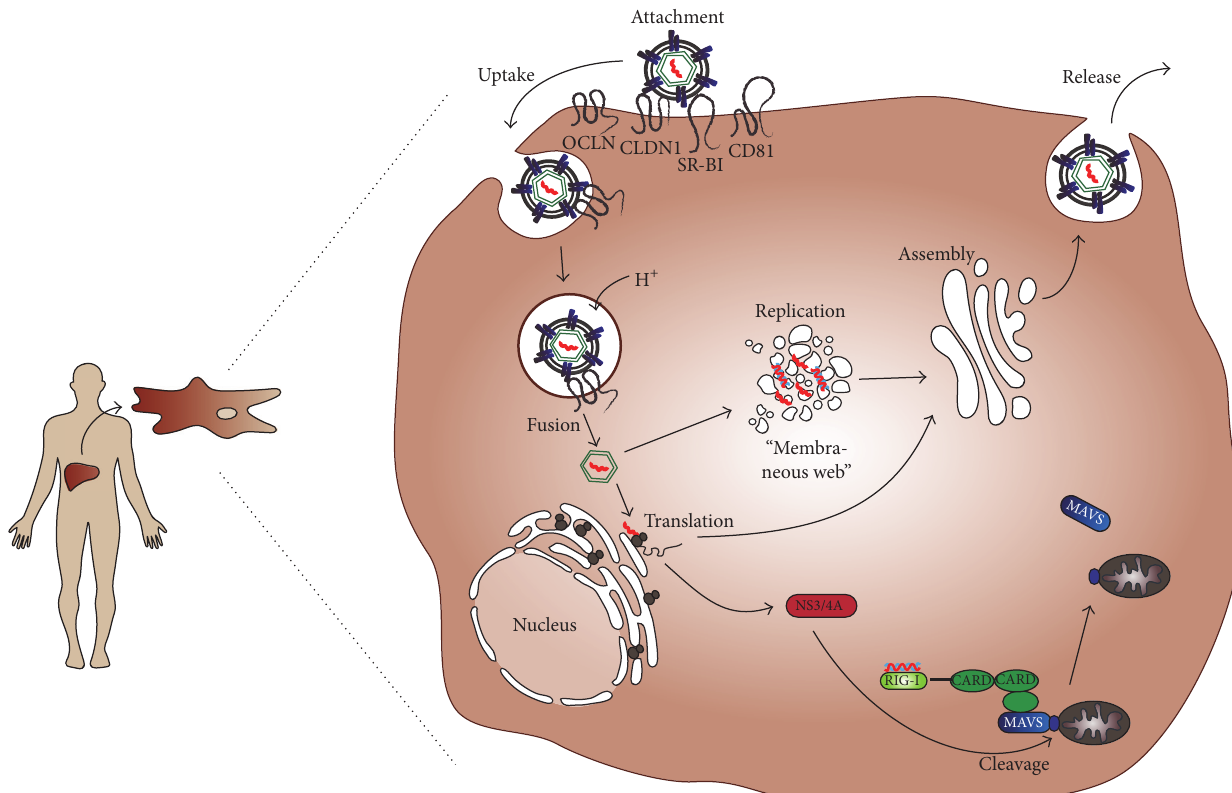
Figure 2: Hepatitis C virus life cycle and MAVS cleavage. Upon transmission, HCV enters hepatocytes in a multistep process involving the four host factors SR-BI, CD81, CLDN1, and OCLN. After uptake and pH-dependent fusion of viral and endosomal membranes, HCV releases its RNA genome into the cytosol of the host cell. Replication via double-stranded RNA intermediates takes place in the membranous web, consistingofER-derivedstructures.HCVRNAisthentranslatedintoaprecursorprotein,whichiscleavedintotenmatureviralstructuraland nonstructural (NS) proteins. One of the latter, NS3/4A, can proteolytically cleave and by this inactivate MAVS, a RIG-I and MDA5 adaptor protein, which is important for mounting an innate immune response against HCV infection (see text and Figure 3 for